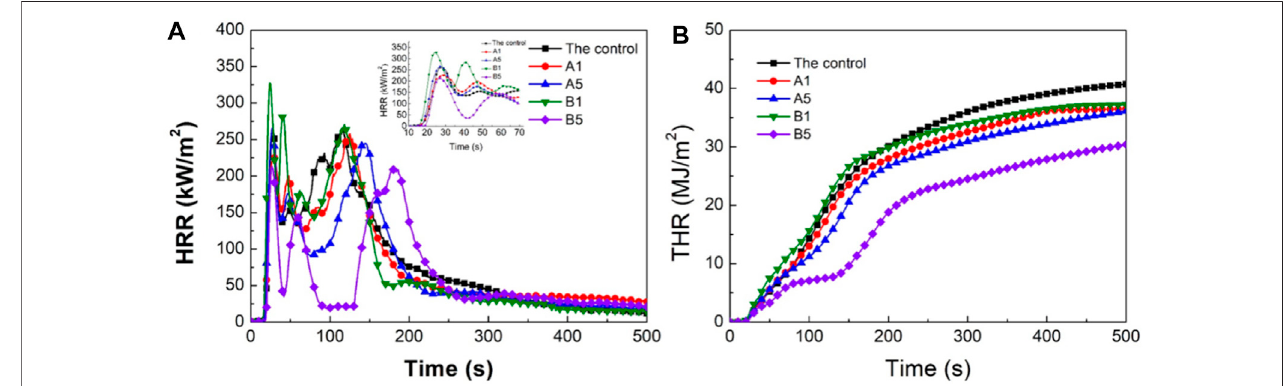
FIGURE 5 | HRR (A) and THR (B) curves of bamboo specimens before and after LbL self-assembly with PA-PEI.